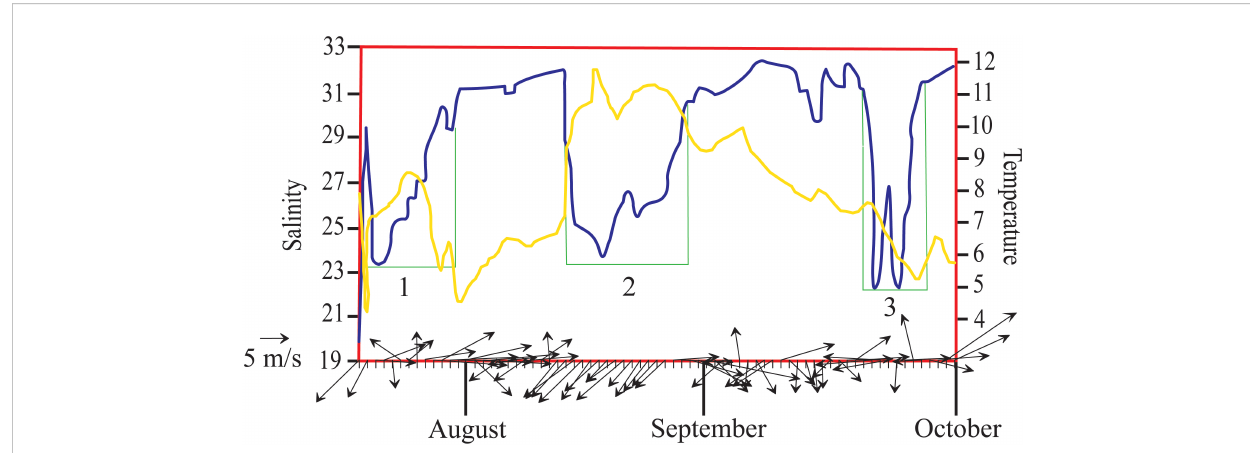
FIGURE 9 Daily temperature (yellow line) and salinity (blue line) measurements in the surface layer on 20 July – 1 October 2002 and the accompanying wind forcing conditions in the Pechora Sea (arrows). Three periods of reduced salinity are indicated by green lines and